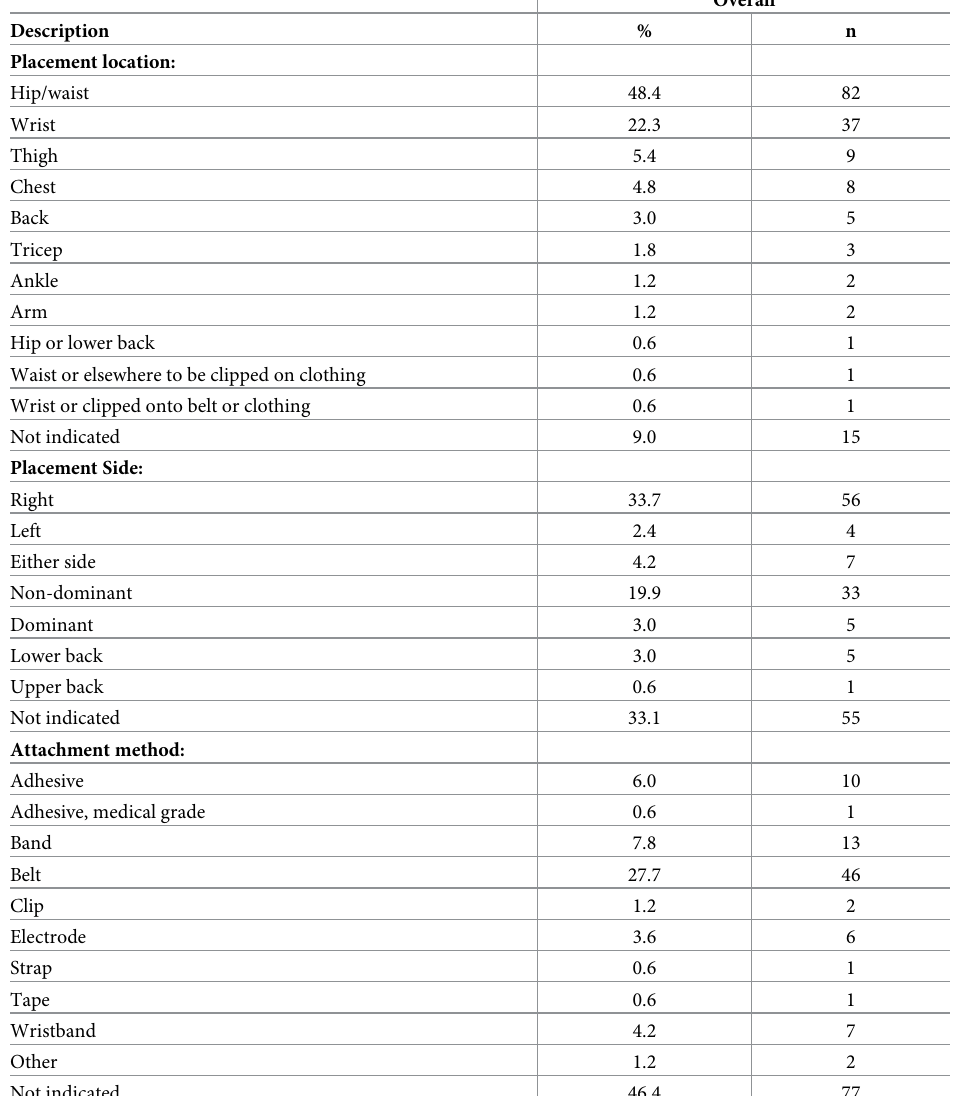
Table 3. Description of accelerometer placement and attachment method used by observational studies of adults (n = 166).